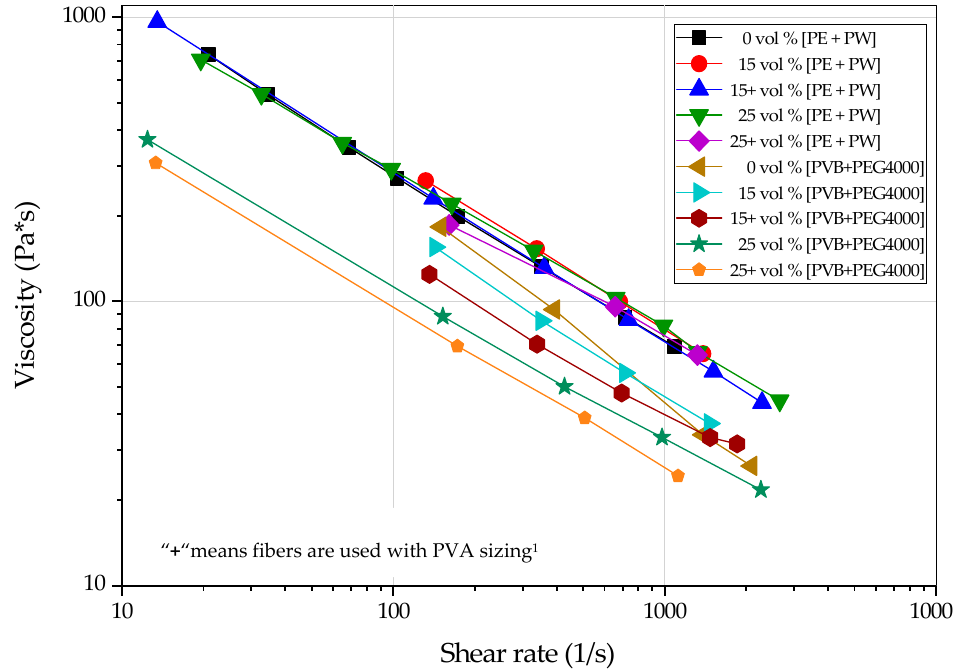
Figure 11. The viscosities of feedstocks with two binding systems and increasing amounts of fibers with/out PVA sizing at 160 °C. Table 5. The effect of PVA sizing on viscosities of different feedstock